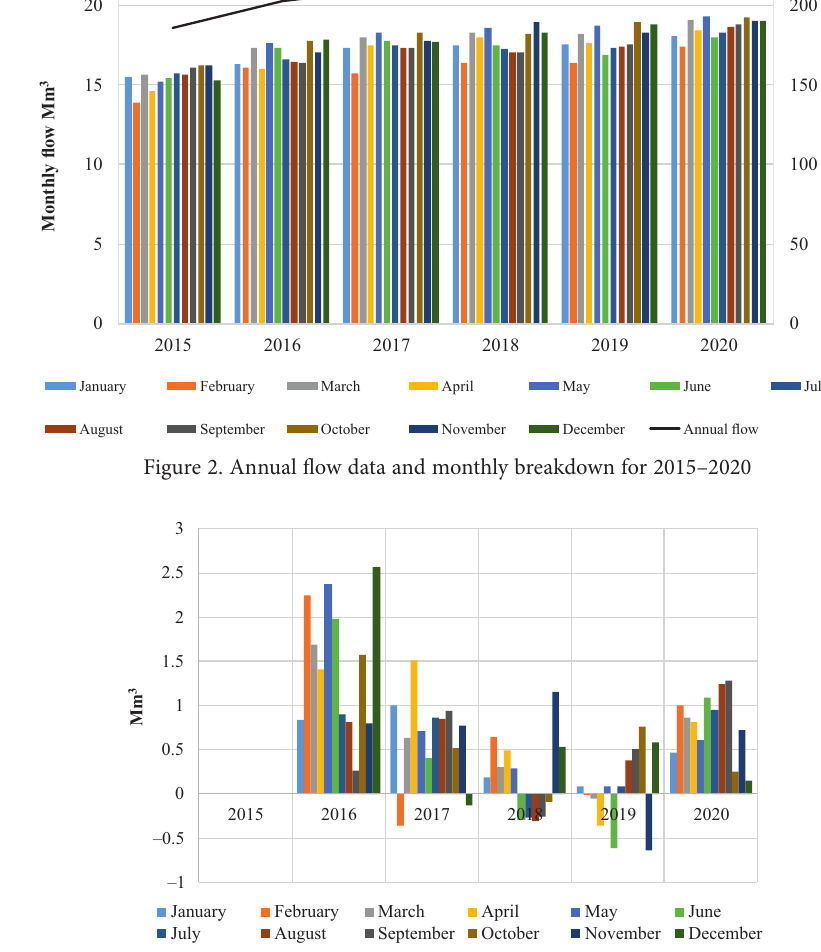
Figure 3. Monthly flow increments for 2015–2020, taking 2015 as a base